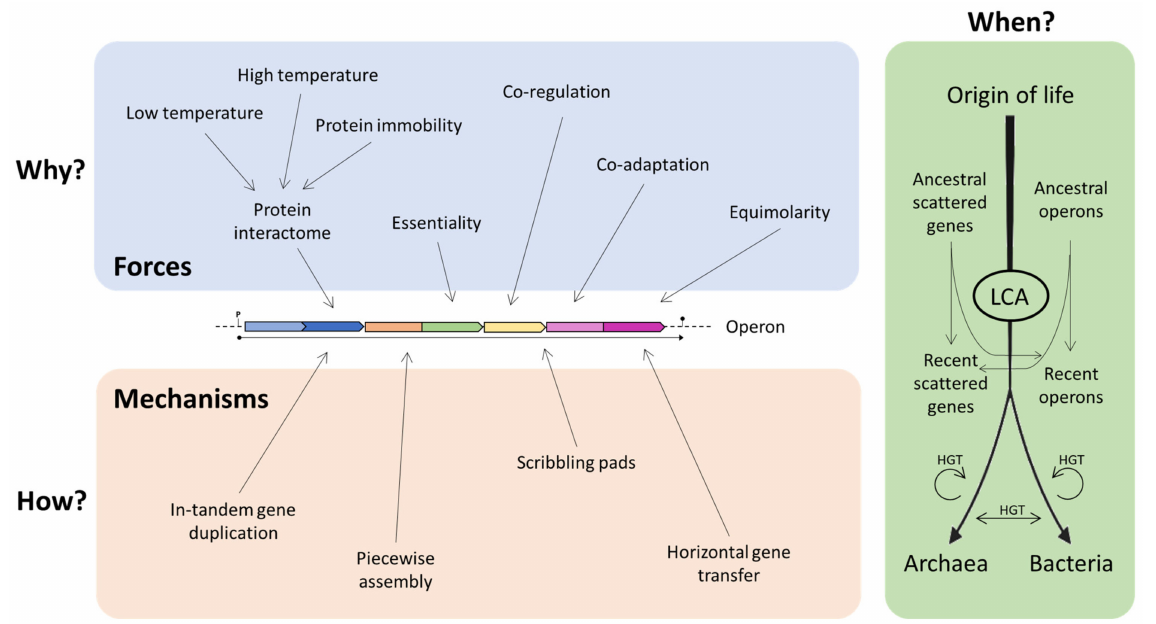
Figure 7. Different forces/mechanisms that contributed to the operon construction. LCA: last common